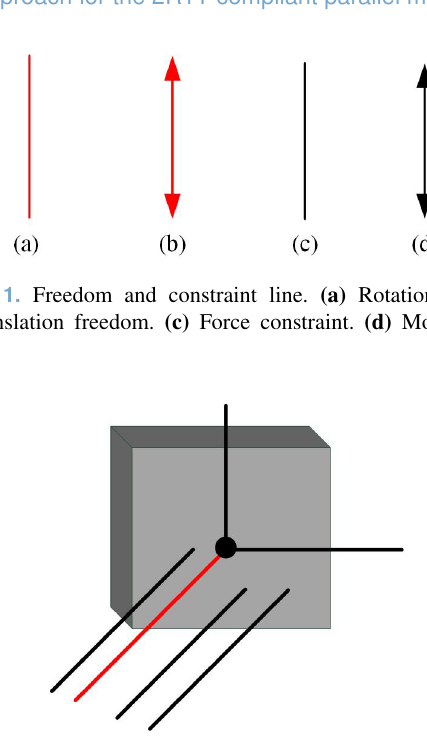
Figure 2. The relationship of the freedom line and all constraint